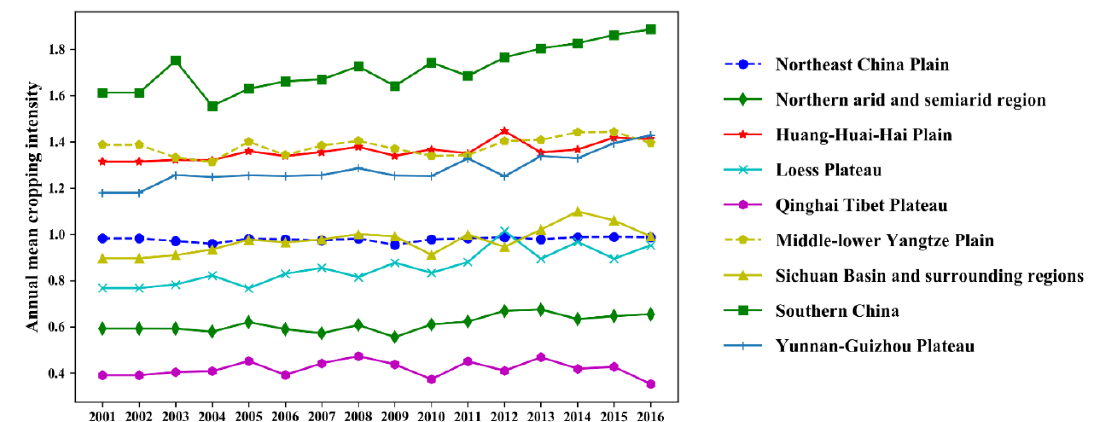
Figure 2. Annual mean cropping intensity maps for each individual year and the sixteen-year mean cropping intensity map in China from 2001 to 2016.